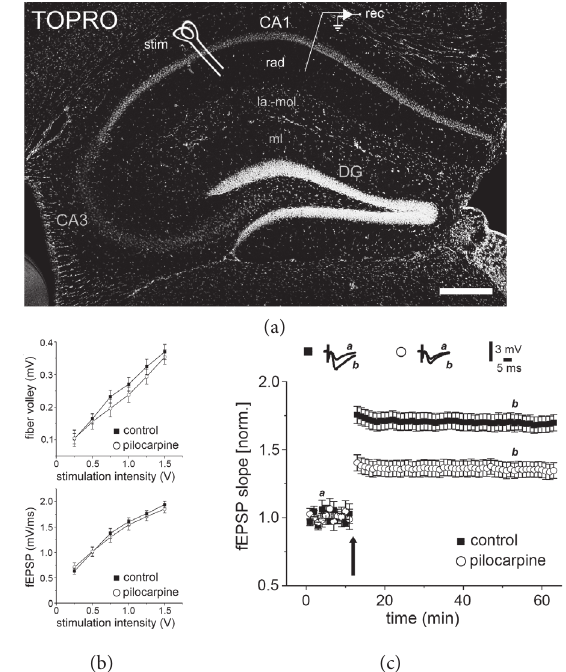
Figure 3: Pilocarpine-induced status epilepticus affects long-term potentiation (LTP) of Schaffer collateral-CA1 synapses. (a–c) LTP of Schaffer collateral-CA1 synapses was probed in acute dorsal hippocampal slices. A single 100Hz tetanus (1s) is applied (stim), to induce LTP (recordings of field excitatory postsynaptic potentials; fEPSP) in slices prepared from either pilocarpine- or vehicle- injected animals (stratum radiatum, rad; stratum lacunosum- moleculare, la.-mol.; stratum moleculare, mL; dentate gyrus, DG; nuclear stain, TO-PRO; scale bar: 200 𝜇 m). While no significant difference in fiber volleys and input/output properties is detected (b), a deficit in the ability to induce LTP at Schaffer collateral-CA1 synapses isobserved in thepilocarpine group (c). Values normalized to baseline fEPSP slope. control 50 min = 1.69 ± 0.06 , pilocarpine 50 min = 1.35 ± 0.05 ; 𝑃 = 0.001 ; 𝑁 = 9 slices (1 slice per animal) of each group. 𝑡 -test (unpaired,